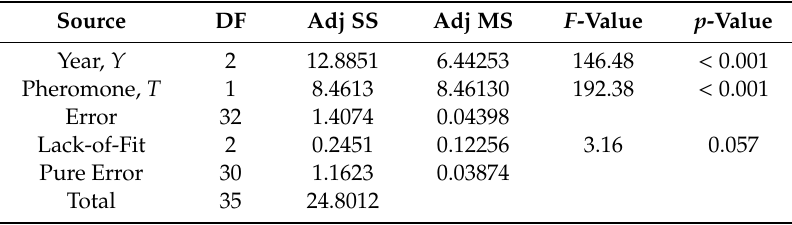
Table 1. E ff ects of emerging adult density ( A ), Year ( Y ) and pheromone treatment ( T ) on total capture of males per pheromone trap, Equation (1)